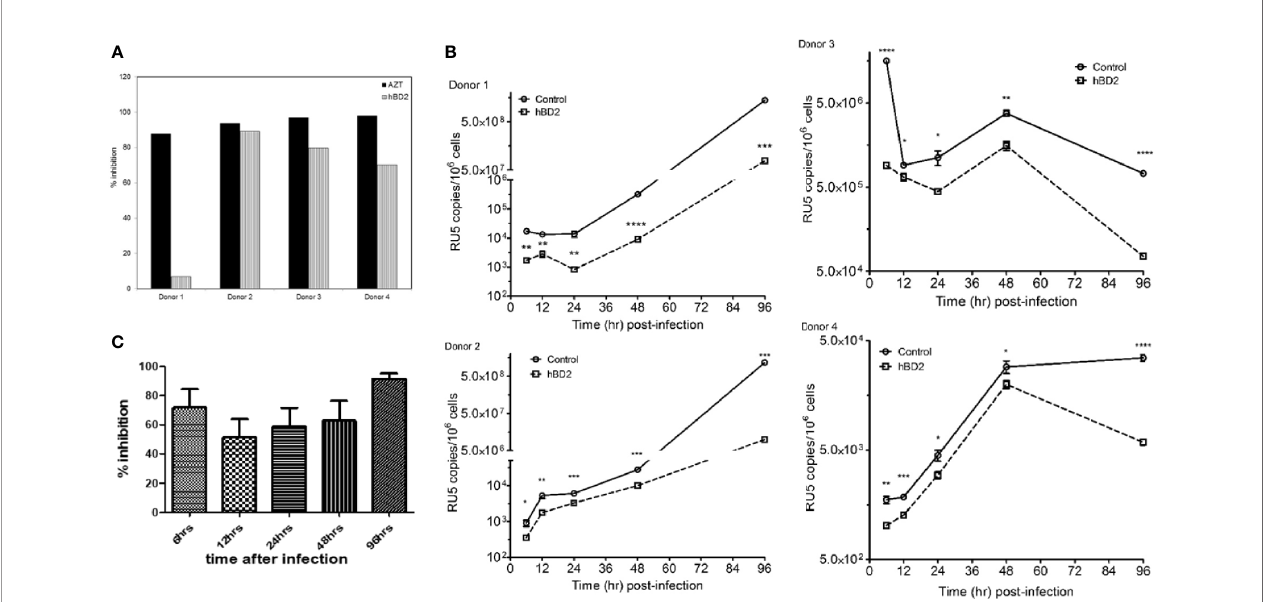
FIGURE 3 | hBD2 suppresses HIV-1 at an early post-entry stage. (A) Single-cycle infection of MDM. Cells were infected with HIV-luciferase pseudotyped with AMLV envelope. After infection, cells were incubated 3 days in presence or absence of hBD2. Subsequently, cells were lysed and luciferase activity was measured. Percentage of inhibition was calculated for treated infected cells in reference to untreated infected cells. Data are presented for independent experiments from 4 different donors. (B) hBD2 inhibits accumulation of early reverse transcription products of HIV-1. MDM were challenged with DNase I-treated HIV-1 BaL . Post- infection, hBD2 was added to the cultures. Total cellular DNA was isolated at the indicated time points and copies of LTR/RU5 products of reverse transcription were measured in triplicate by real-time PCR. Readings were averaged ± SEM and are presented as copies per million cells; log-scale graph. *P < 0.05, **P < 0.005, ***P < 0.0005, ****P < 0.0001 between treatment and control groups determined with unpaired two-tailed t test. Data are presented for independent experiments from 4 different donors and (C) summary graph of the average inhibition for the four donors shown in 3B was determined as the percentage of HIV-1 DNA copies in treated infected cells in reference to untreated infected